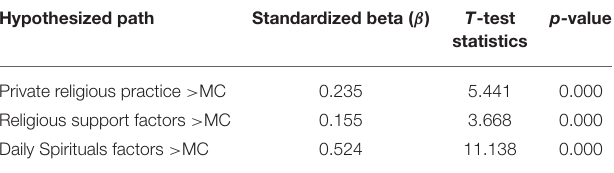
TABLE 10 | Beta values ( β ) and t-statistic values.